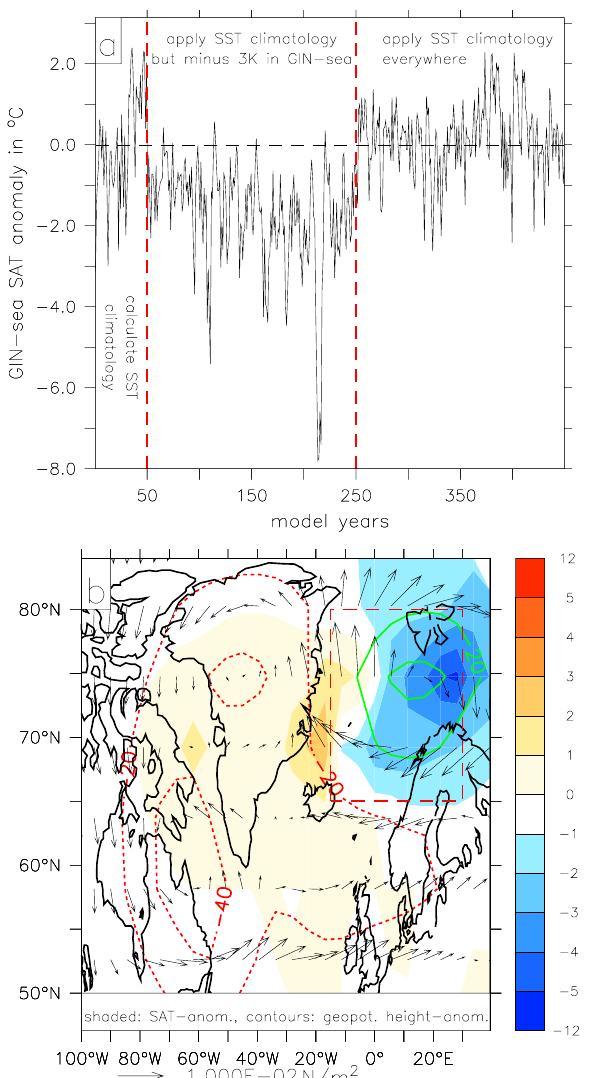
Fig. 5. (a) GIN Sea SAT anomaly (averaged over 15 ◦ W to 30 ◦ E and 65 ◦ N to 80 ◦ N) with respect to the model years 1 to 50 of the sensitivity experiment. The red lines separate the three stages of the experiment. (b) Anomalies in SAT in K (shaded), 800mbar geopotential height in m 2 /s 2 (contours) and wind stress (arrows) with respect to the model years 1 to 50 of the sensitivity experiment. The red rectangular indicates the region where the SST perturbation is applied to the GIN Sea atmosphere. Please refer to Sect. 4.3 for details.